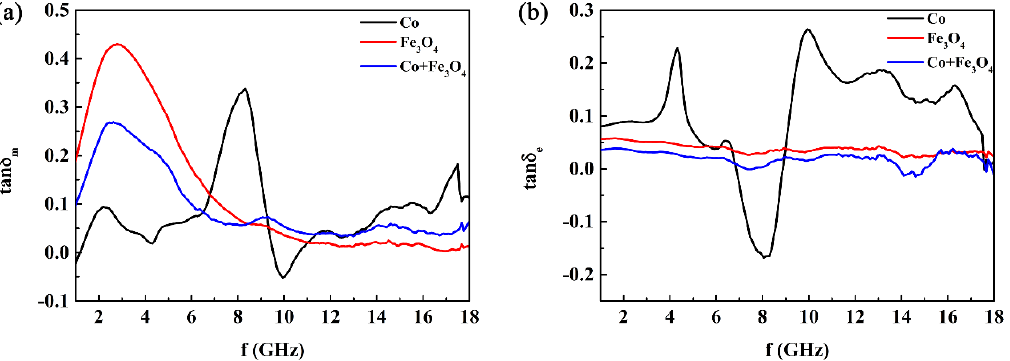
Figure 8. ( a ) Magnetic loss angle tangent (𝑡𝑎𝑛𝛿 (cid:3040) ) and ( b ) dielectric loss angle tangent (𝑡𝑎𝑛𝛿 (cid:3032) )